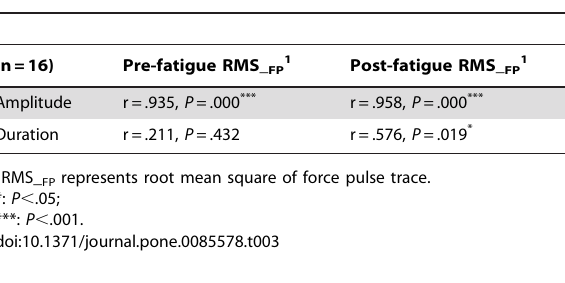
Table 3. Pearson’s correlation coefficients between the size of force fluctuations and force pulse